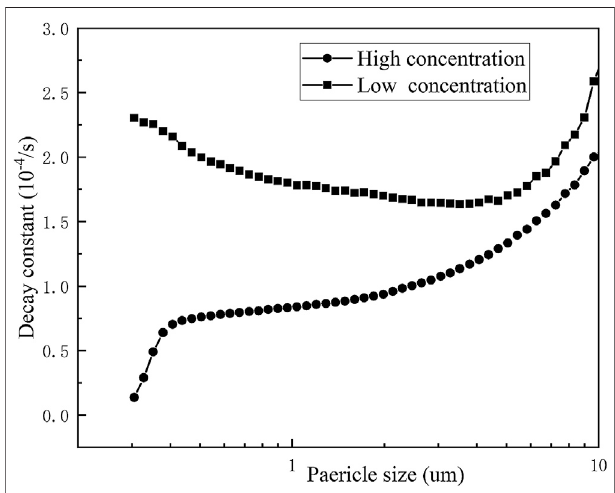
FIGURE 10 | Variation of decay constant with particle size. Presence of